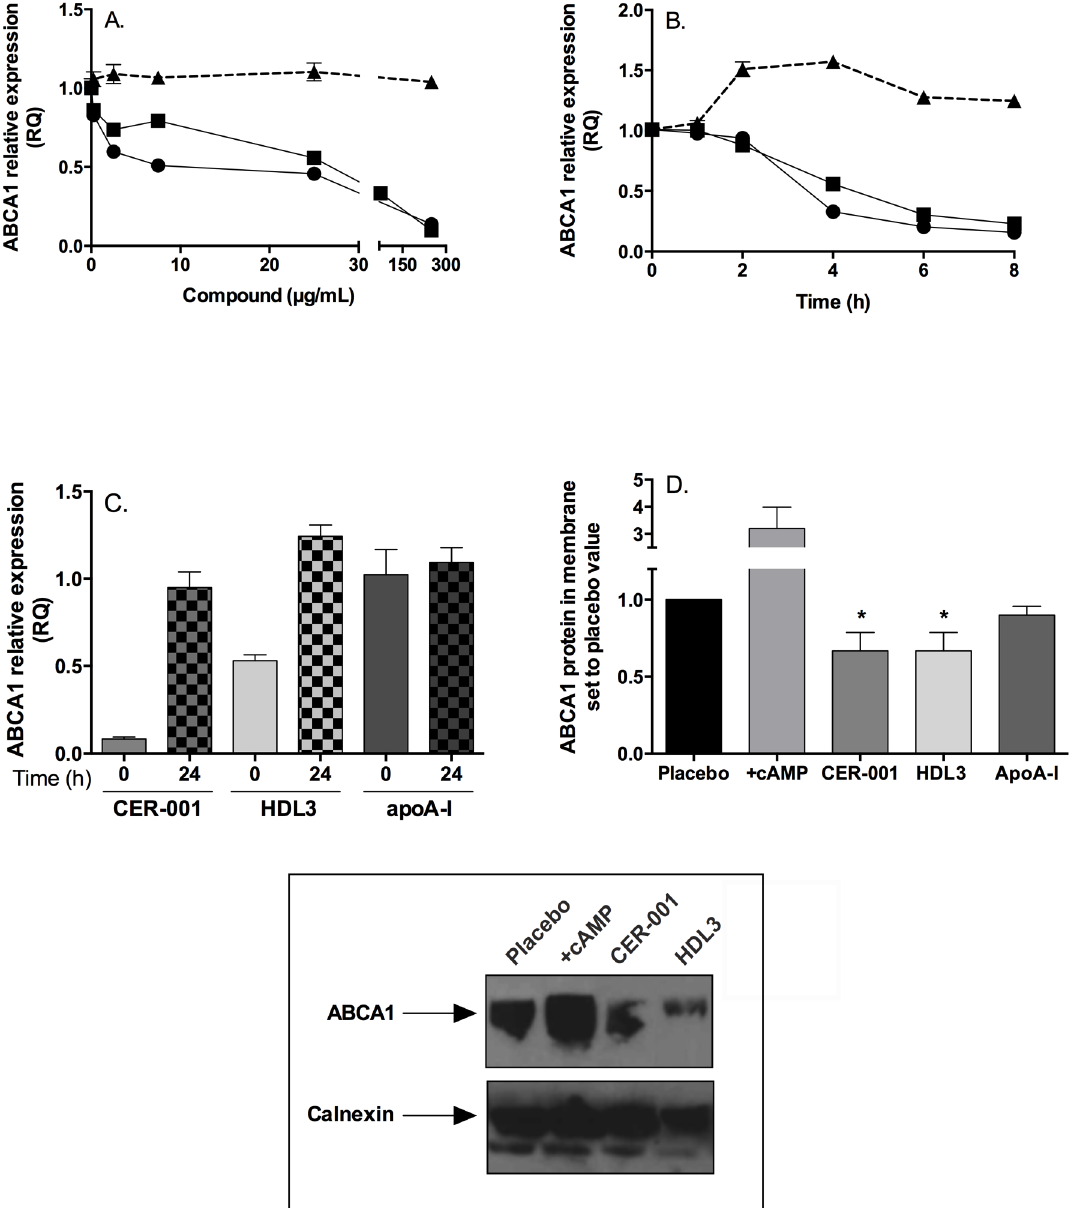
Fig 2. ABCA1 mRNA and protein decrease in J774 macrophages following CER-001 and HDL3 incubation. Panel A; ABCA1 mRNA level in J774 macrophages was determined in presence of different concentrations of CER-001, HDL3 or delipidated apoA-I for 24h. Panel B; Kinetic of ABCA1 mRNA level at a fixed concentration (250 μ g/mL) of CER-001, HDL3 or delipidated apoA-I. The qPCR data represent the means of triplicate determinations from a single experiment that is representative of three such experiments. Panel C; J774 macrophages were treated for 24 h in presence of CER-001, HDL3 or delipidated apoA-I at 250 μ g/mL (time 0). Compounds were removed and replaced with fresh medium for 24 h (time 24) and ABCA1 mRNA level was determined by qPCR. Panel D; The relative membrane protein expression of ABCA1 was measured by Western blot analysis for macrophages treated for 6h with CER-001, HDL3 or apoA-I at 250 μ g/ml. cAMP was used for 24h at 300 μ M. Membrane protein loading for each sample was verified by Western blot using rabbit anti-Calnexin (1/1000 dilution). Membrane fractions were obtained after ultracentrifugation as described in Material & Method section. The data represent the means of triplicate determinations from a single experiment. * p > 0.05.